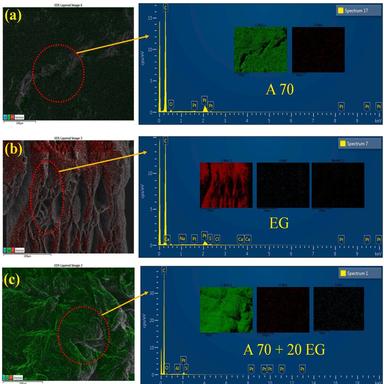
EDX evaluation of SS-PCM composites: (a) A70 PCM, (b) EG nanoparticle, and (c) A70 + 20EG SS-PCM composite.